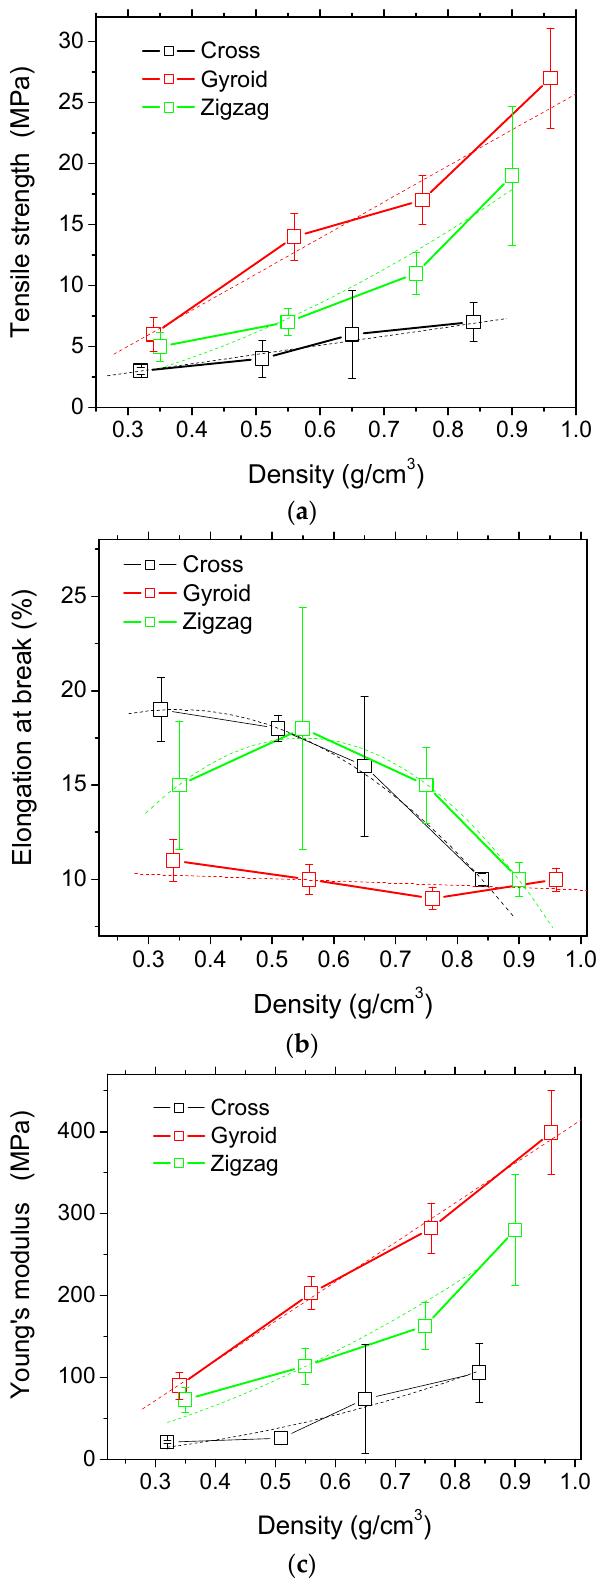
Figure 5. Correlations between engineering constants and the density of PLA–carbon fibre patterns: ( a ) tensile strength, ( b ) elongation at break, ( c ) Young’s